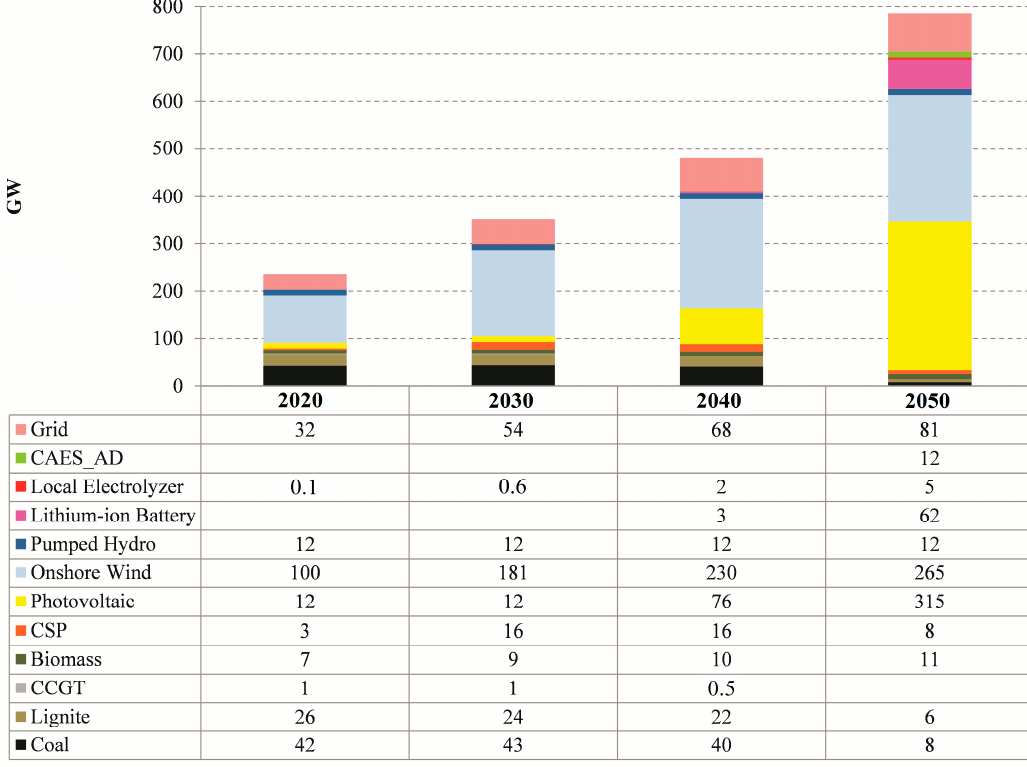
Figure 8. Total installed capacity by technology in the supply region of Inner Mongolia.